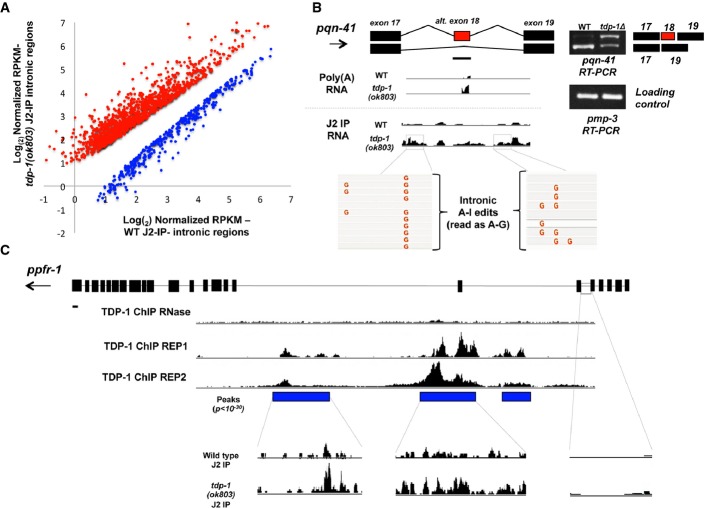
TDP-1 directly limits the dsRNA structure or stability of intronic RNALog2 fold change of tdp-1(ok803) J2-IP/wild-type J2-IP (x-axis) for all expressed intronic regions selected in the J2-IP graphed according to increasing number of reads that map to each region (x-axis). Abundance levels for introns were normalized to input (see Materials and Methods for details). All introns selected in the J2-IP that are significantly (P < 0.05, FDR < 0.1, three biologically independent replicates) increased (red dots) and decreased (blue dots) between tdp-1 mutant and wild-type J2-IP are shown. See Supplementary Table S9.Example of a tdp-1(ok803) J2-IP enriched intronic region that exhibits altered splicing in tdp-1(ok803) polyA RNA-seq. Coverage tracks from poly(A) RNA-seq and J2-IP RNA-seq are displayed for pqn-41 (ChrIII: 1,931,953–1,934,515). A-to-I RNA editing patterns in the boxed regions for each transcript are also depicted. Arrows depict the direction of transcription, and scale bars (solid black line below gene model) are set to 250 bp.ChIP-seq pattern for TDP-1 within the long, structured gene ppfr-1 (ChrI: 9,364,769-9,393,087). The location of significant TDP-1 peaks in both replicates as well as in the RNase control is shown by blue boxes below the ChIP-seq coverage tracks. The enrichment by anti-dsRNA immunoprecipitation (J2-IP) within regions bound by TDP-1 is displayed below significant peaks. Both wild-type (top) and tdp-1(ok803) (bottom) J2-IP tracks are shown to indicate excess RNA structure when TDP-1 is absent. The J2-IP enrichment for an intron not bound by TDP-1 is also shown. Arrows depict the direction of transcription, and scale bars (solid black line below gene model) are set to 250 bp.Source data are available online for this figure.